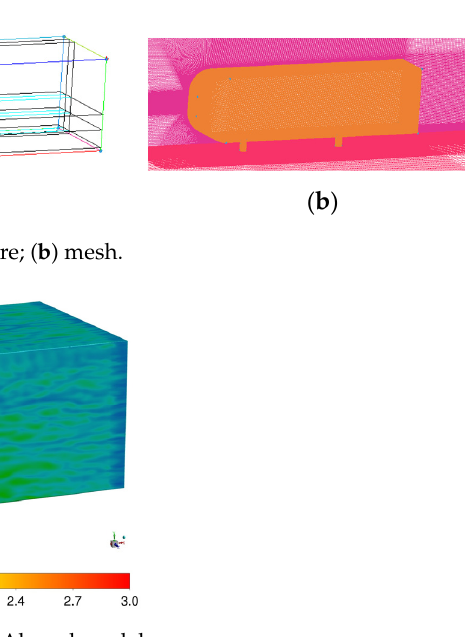
Figure 2. Computational domain and boundary conditions.